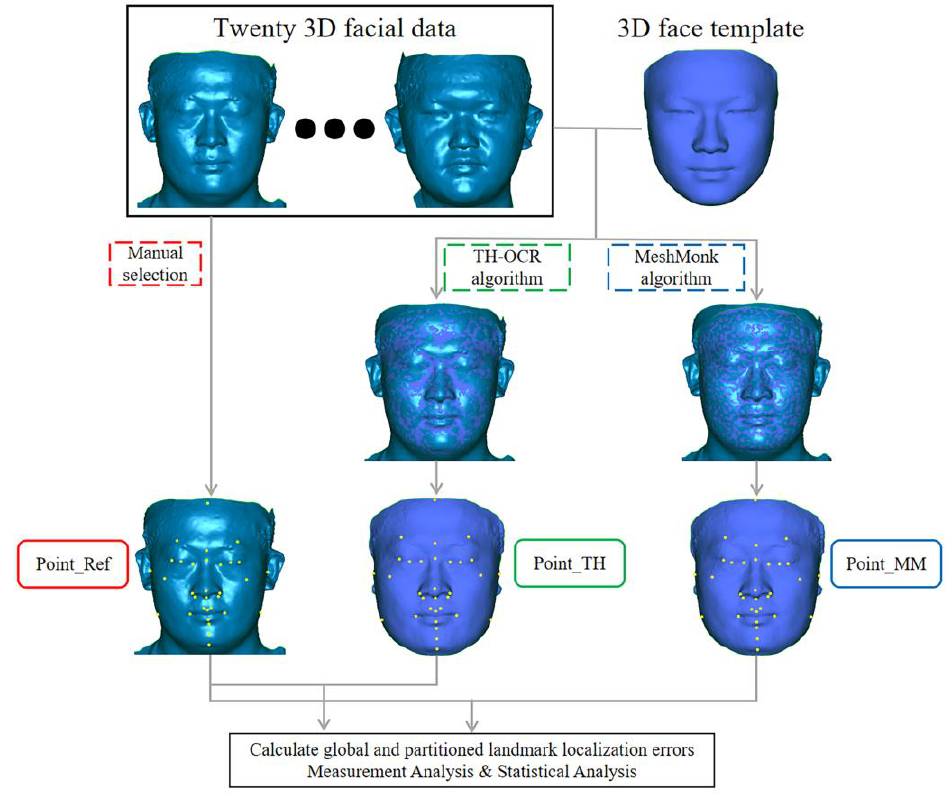
Figure 1. Flow chart depicting the experiment